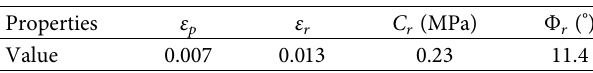
Figure 8: Stress-strain relationship. Table 2: Strain-softening